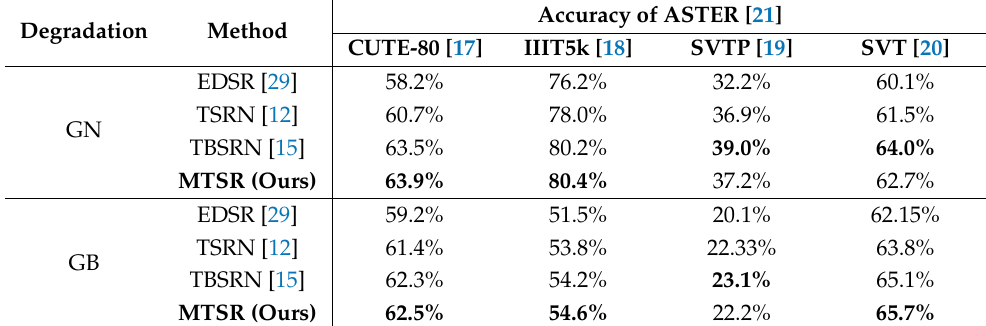
Table 7. Comparison results on scene text recognition benchmarks including CUTE-80